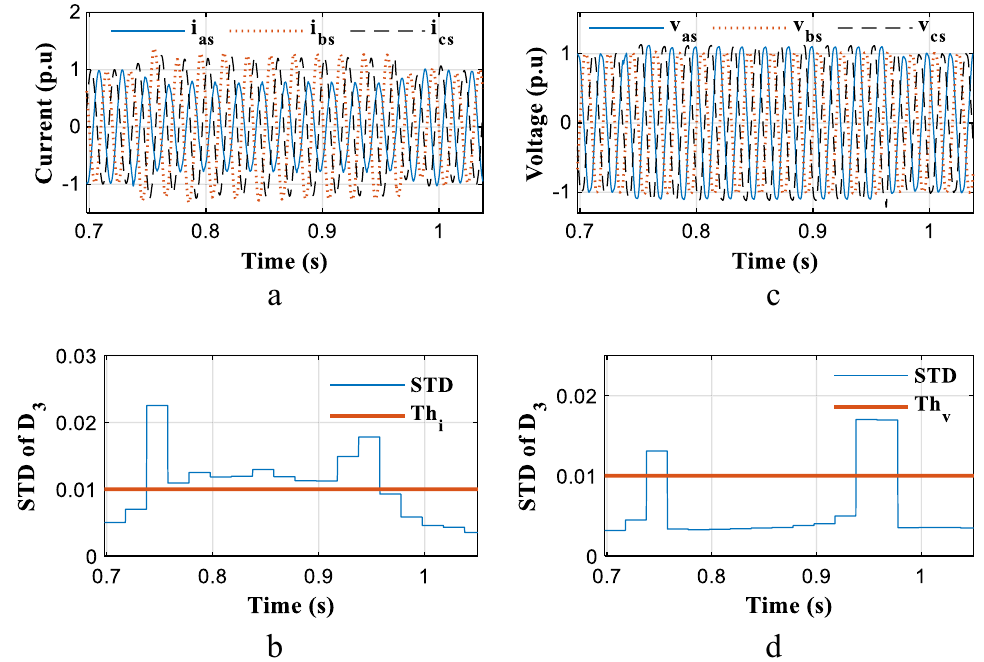
Fig. 18 Performance evaluation of proposed criteria using practical results for a voltage swell 10%, a Three-phase stator current signals, b The current criterion, c Three-phase stator voltage signals, d The voltage